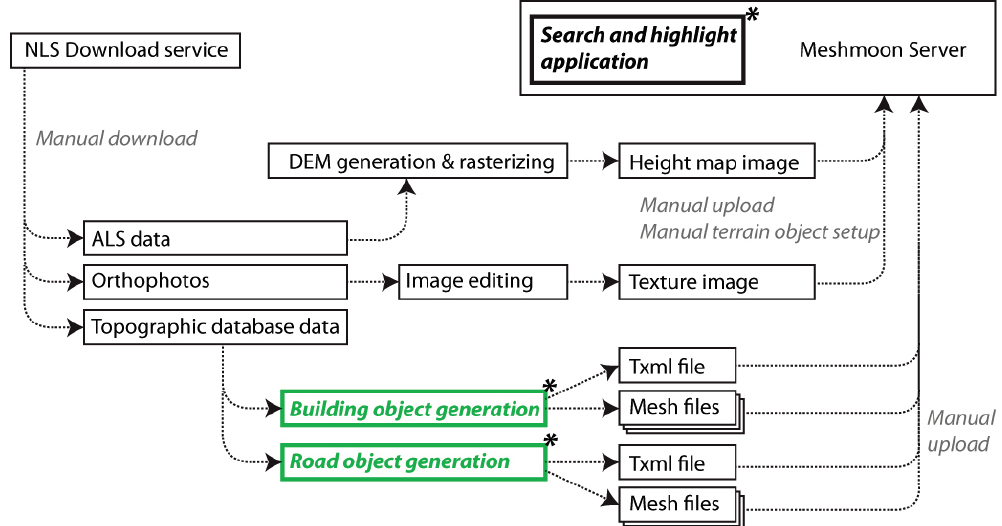
Figure 6. The process of scene creation. Automated steps are marked with green. The software implementations we have developed have been marked with an asterisk.